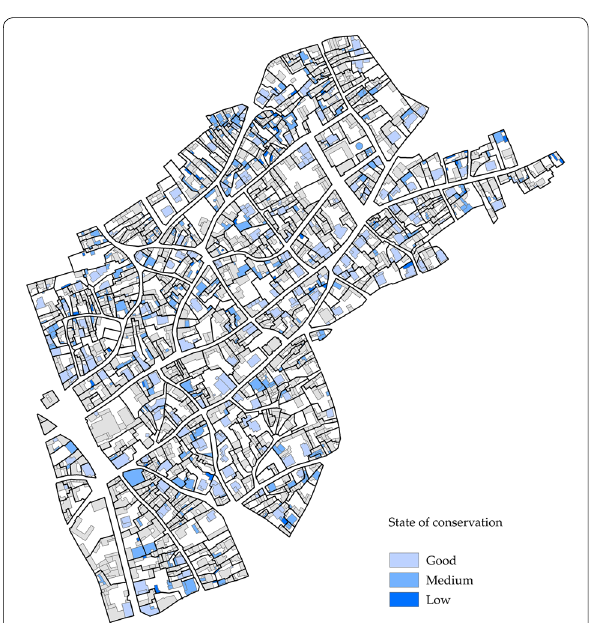
Fig. 4 Typologically incompatible recent buildings by state of